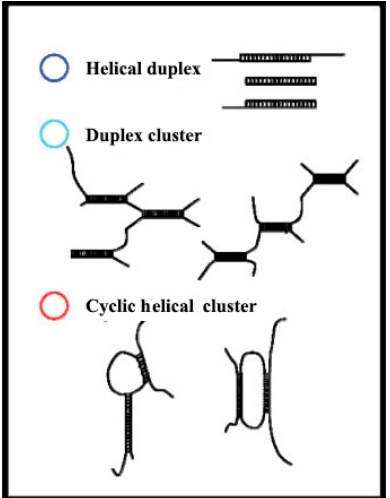
Figure 4. Schematic representation of the different types of helical structures of Pleurotus geesteranus β - D -glucan (reproduced from [18] with permission from John Wiley and Sons, Copyright 2009).